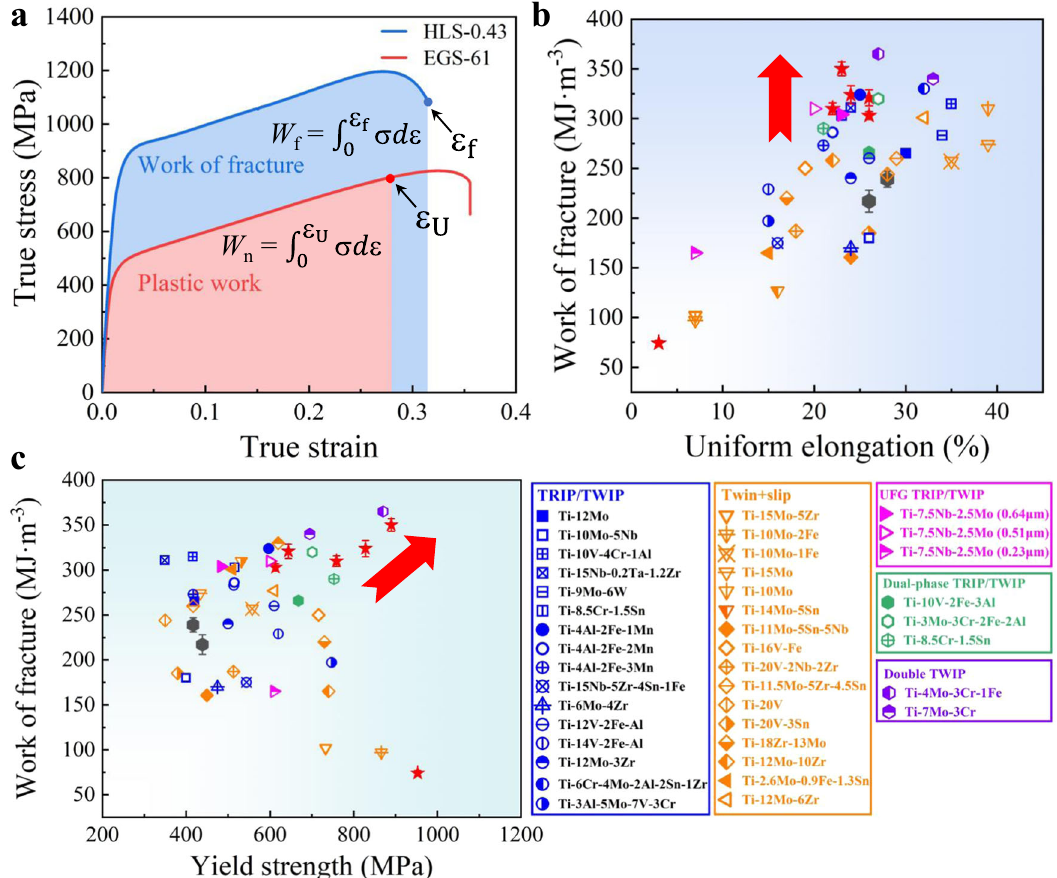
Fig. 4 | The fracture properties of β -Ti alloys. a The true stress – strain curves of HLS-0.43 and EGS-61 β -Ti alloys. The red and blue colored areas represent the integration performed to estimate the plastic work and work of fracture, respec- tively.Comparisonsof b theworkoffracturevs.trueuniformstrainand c thework offracturevs.yieldstrengthofour β -Tialloyswithreportedmetastable β -Tialloys, includingTRIP/TWIPTialloys:Ti-12Mo 9,54 ,Ti-10Mo-5Nb 43 ,Ti-10V-4Cr-1Al 10 ,Ti-15Nb- 0.2Ta-1.2Zr 20 , Ti-9Mo-6W 26 , Ti-8.5Cr-1.5Sn 37 , (Ti-4Al-2Fe-1Mn, Ti-4Al-2Fe-2Mn and Ti-4Al-2Fe-3Mn) 38 , Ti-15Nb-5Zr-4Sn-1Fe 39 , Ti-6Mo-4Zr 51 , (Ti-12V-2Fe-1Al and Ti-14V-